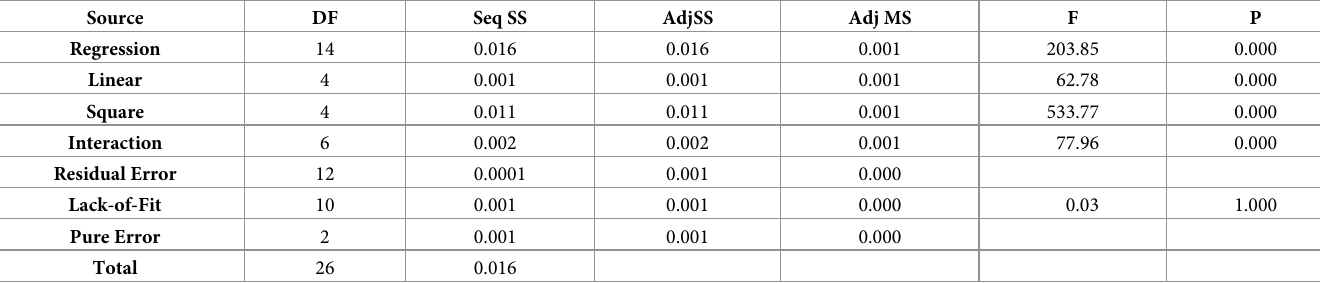
Table 8. Analysis of variance for diosgenin extraction from D . deltoidea by using BBD